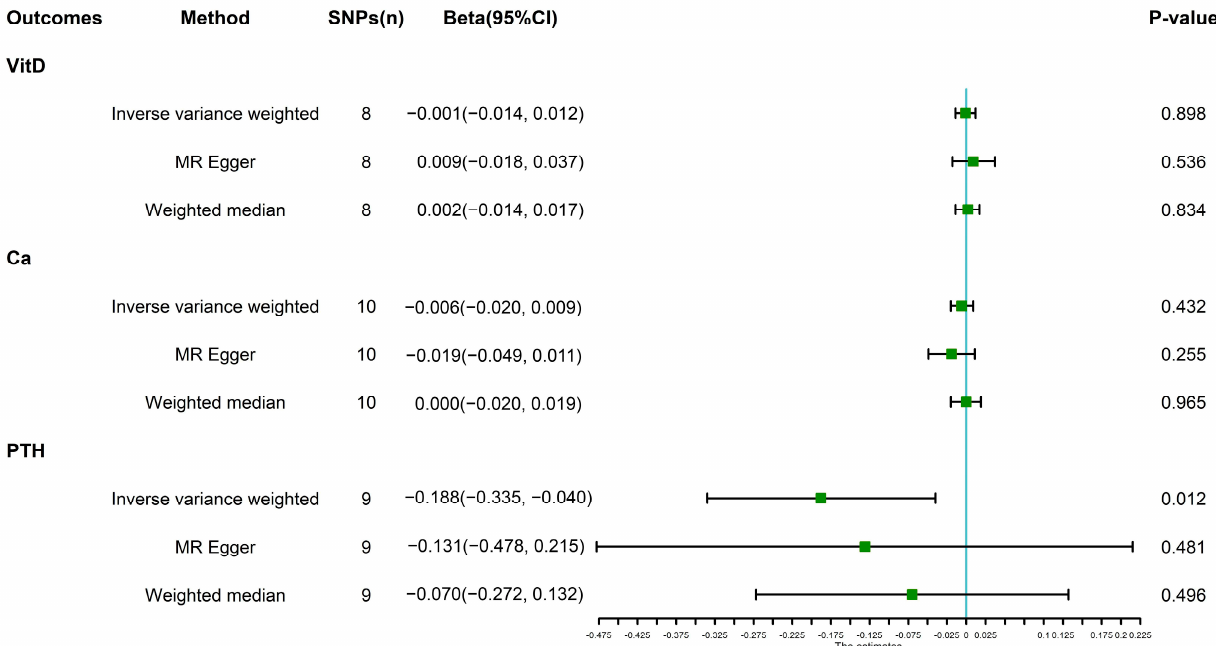
Figure 3. The result of MR analysis investigating the causality between VitD, Ca, and PTH and IBS using multiple approaches. VitD, 25-hydroxyvitamin D; Ca, calcium; PTH, parathyroid hormone; IBS, irritable bowel syndrome; 95% CI, 95% confidence interval.